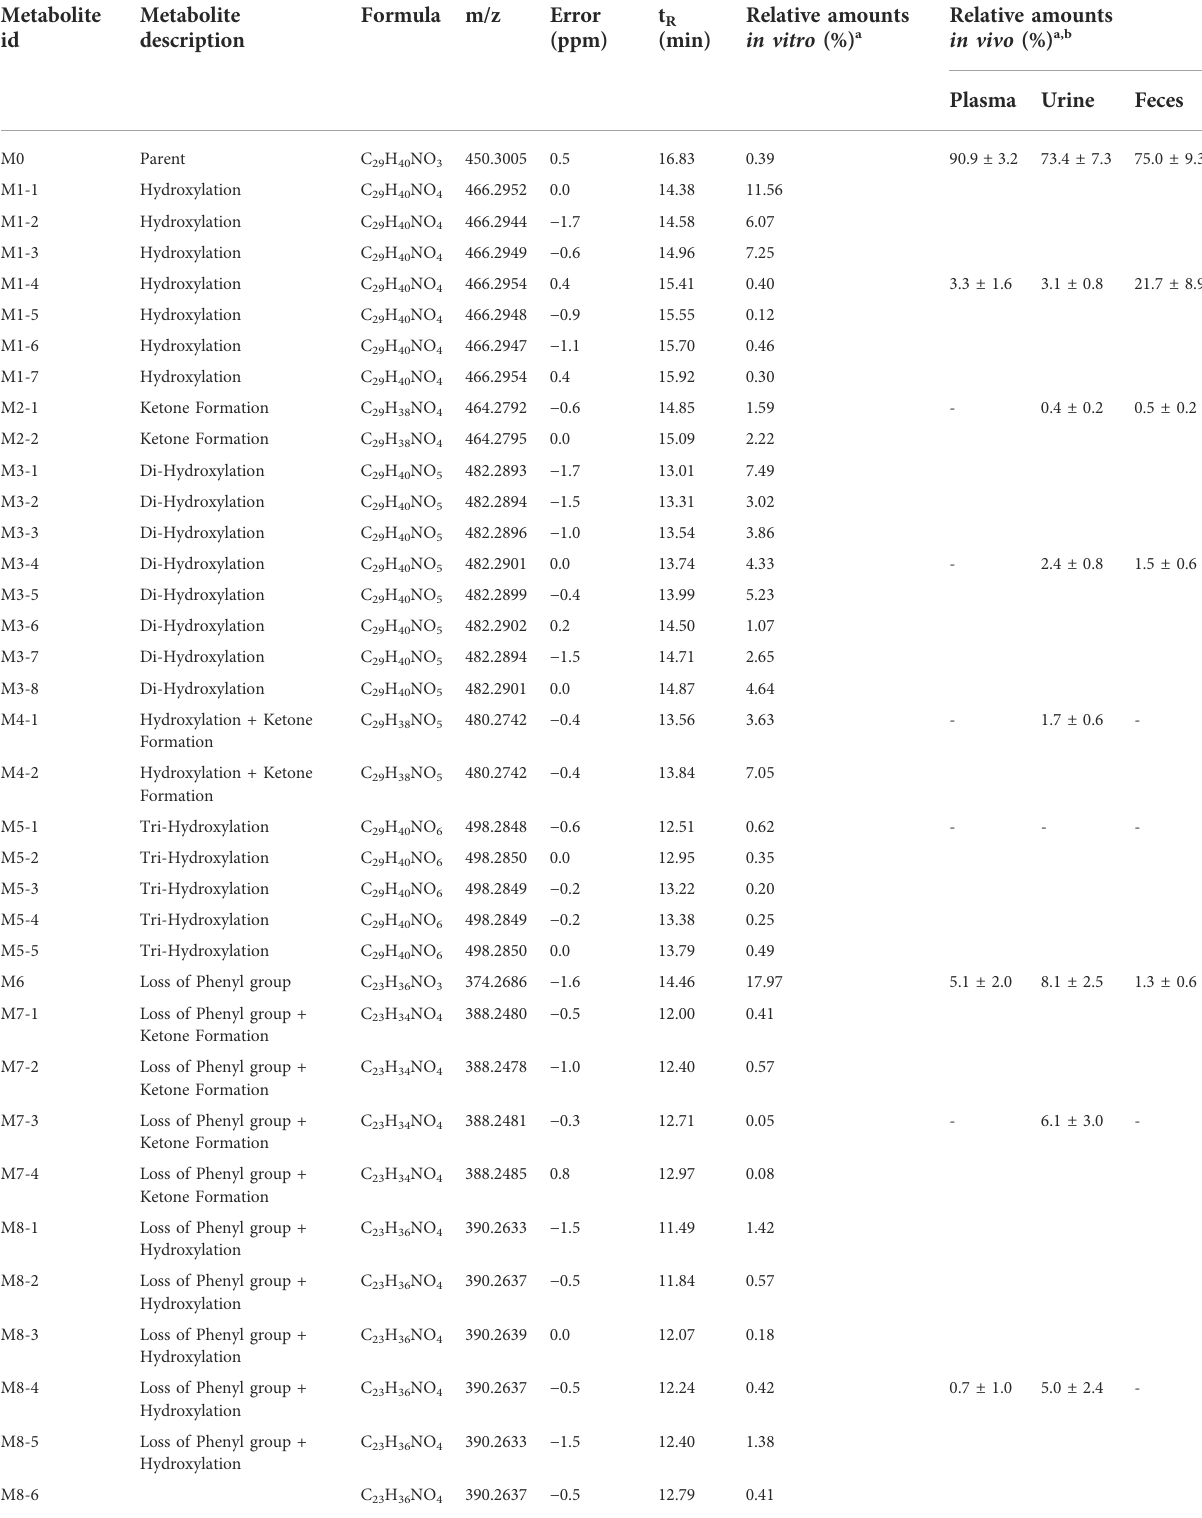
TABLE 3 Summary of 101BHG-D01 and its metabolites in vitro and in vivo . Metabolite